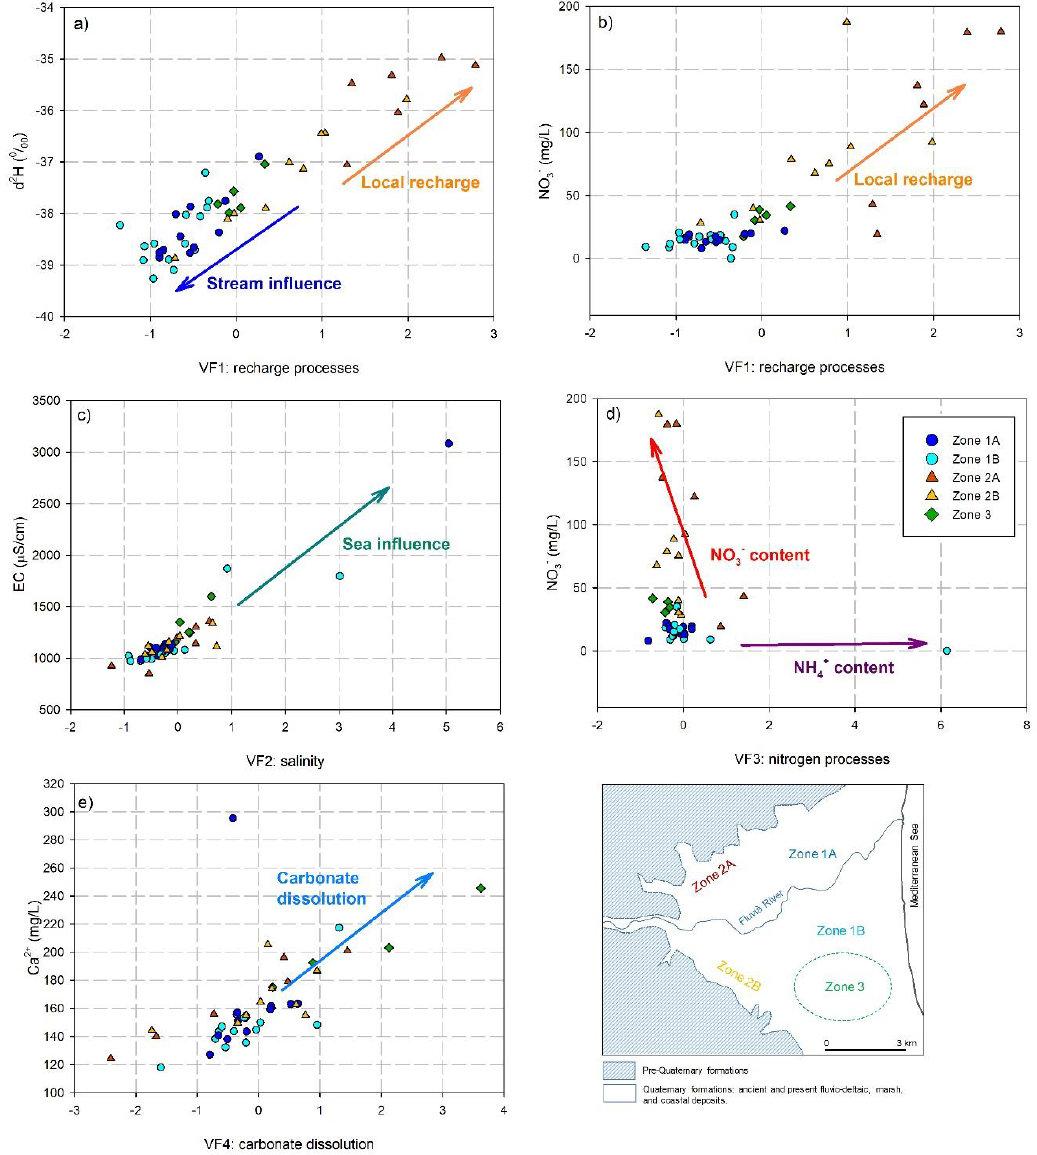
Figure 4. Relationships between varifactors and the main hydrochemical and isotopic parameters: ( a ) VF1 vs. δ 2 H; ( b ) VF1 vs. NO 3 − ; ( c ) VF2 vs. EC; ( d ) VF3 vs. NO 3 − ; and ( e ) VF4 vs. Ca 2 + Table 2. Results of the Redundancy Analysis (RDA). The “raw data” caption assumes that data has